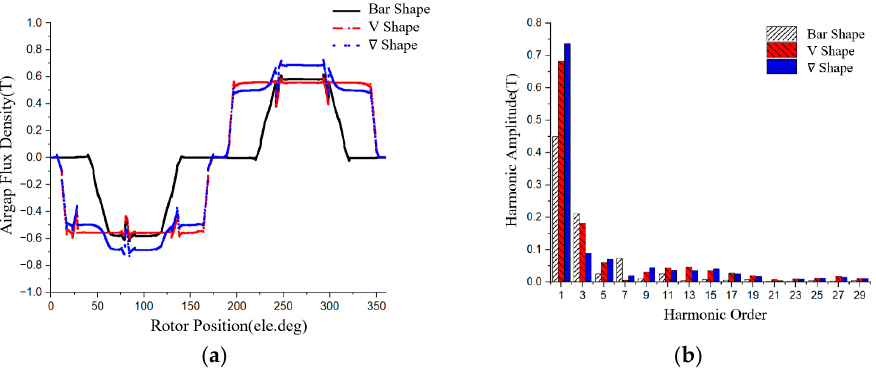
Figure 6. IPMSM rotor structures air gap flux density performance: ( a ) air gap flux density waveform, ( b ) harmonic content.